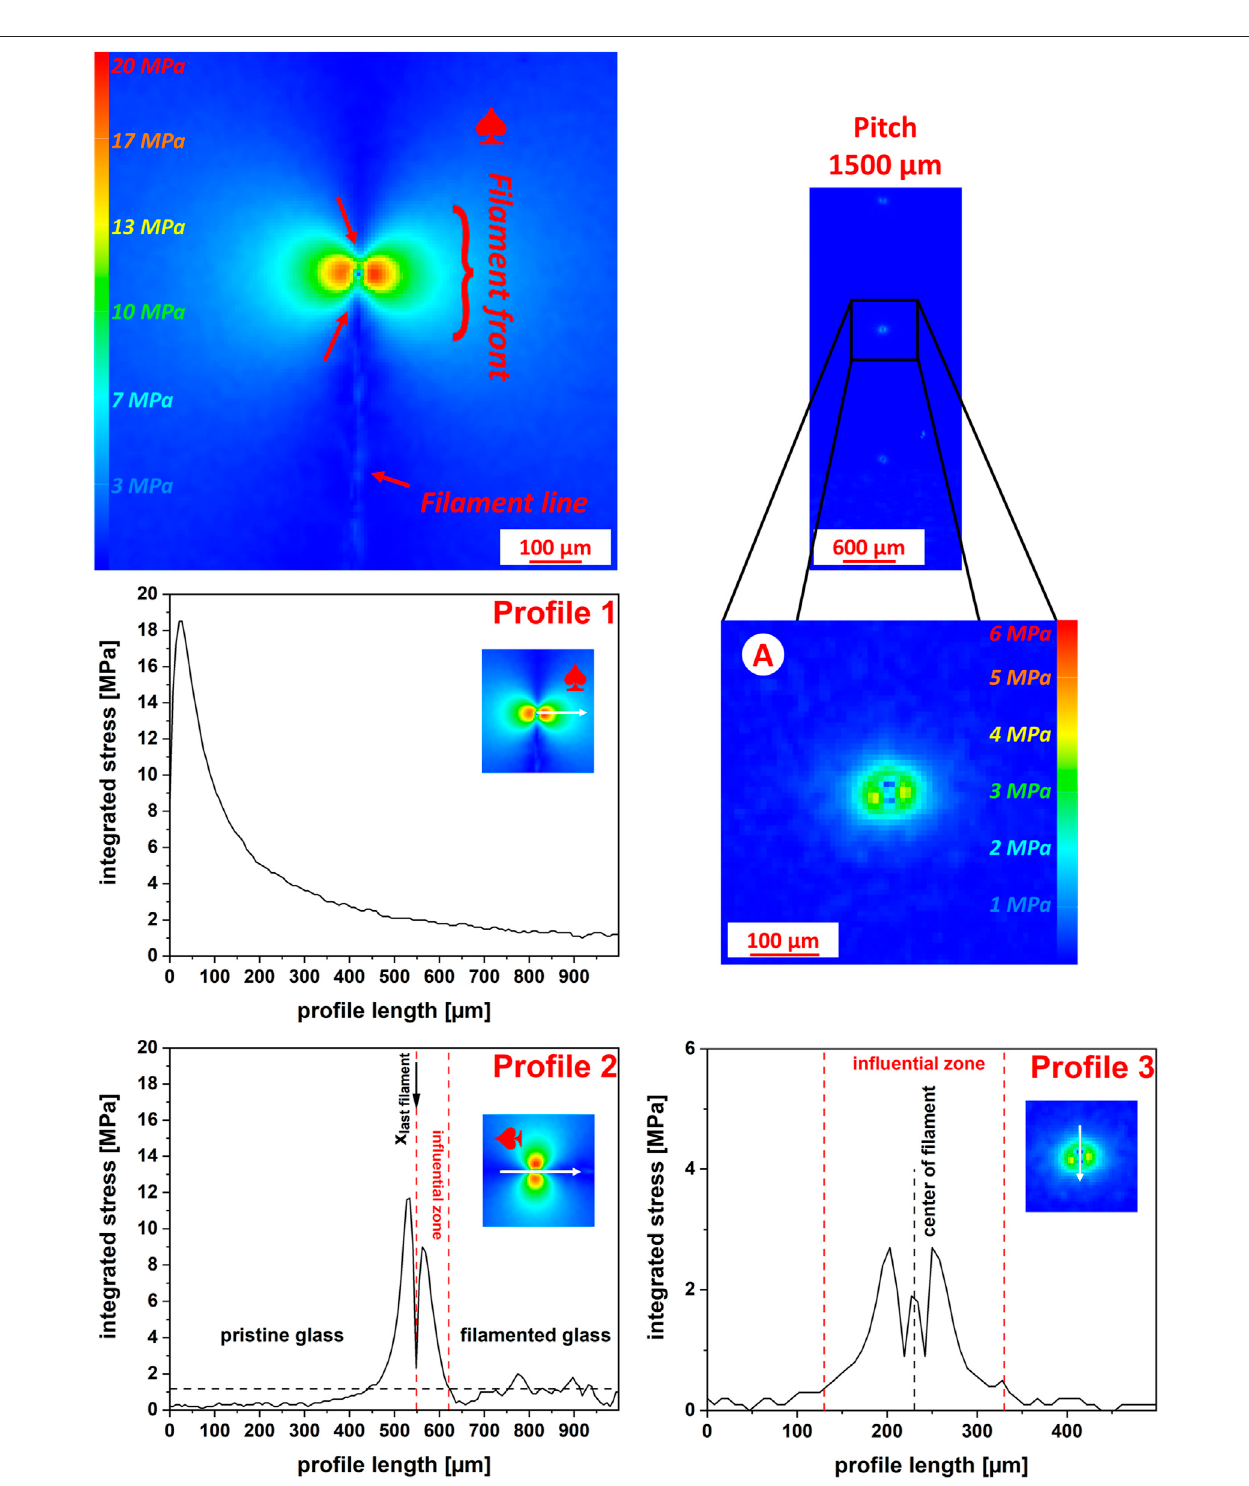
FIGURE 12 | Stress optic image of a fi lament line that ends inside the bulk material with Pitch 5 µm (top left, fi lament front) and well-separated fi lament line with Pitch 1,500 µm (top right). The red arrows at the fi lament line front indicate the directional dependency of the radial cracks. Below, two extracted pro fi les are shown: Pro fi le1(midleft)horizontalextractionasshownbywhitearrowintheinset;Pro fi le2(bottomleft)wasextractedalongthe fi lamentline(whitearrow)reachingfrompristine to fi lamented glass. The position ofthe last scribed fi lament isdetermined at the singularity. The in fl uential zone, where fi lamentsaffecteach other, is determined to be ~100 µm. The magni fi ed region (mid right) shows a singular fi lament with lower stress scale and its corresponding pro fi le 3 (bottom right) shows a symmetric stress